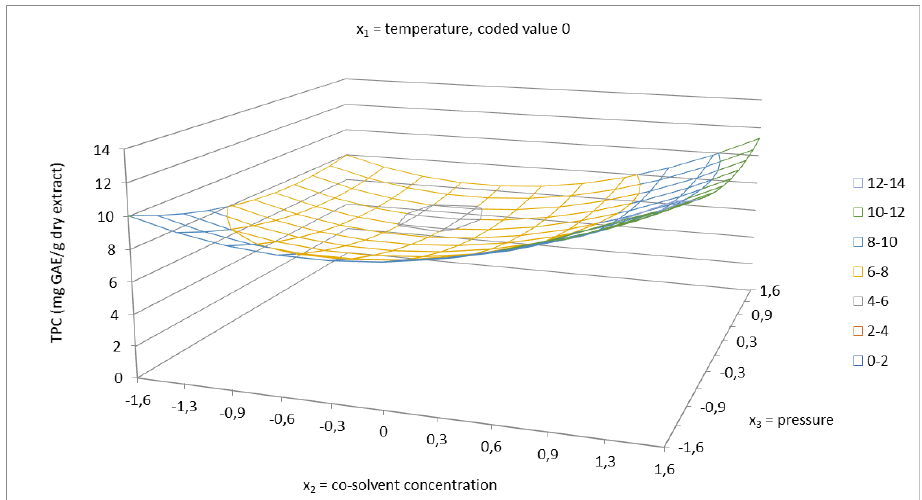
Figure 7. Response surface of total phenolics content as a function of temperature in the range of 40– 100 °C and pressure in the range of 1050–9000 psi in coded values at constant EtOH/water cosolvent concentration of 68.3% (coded value 0).